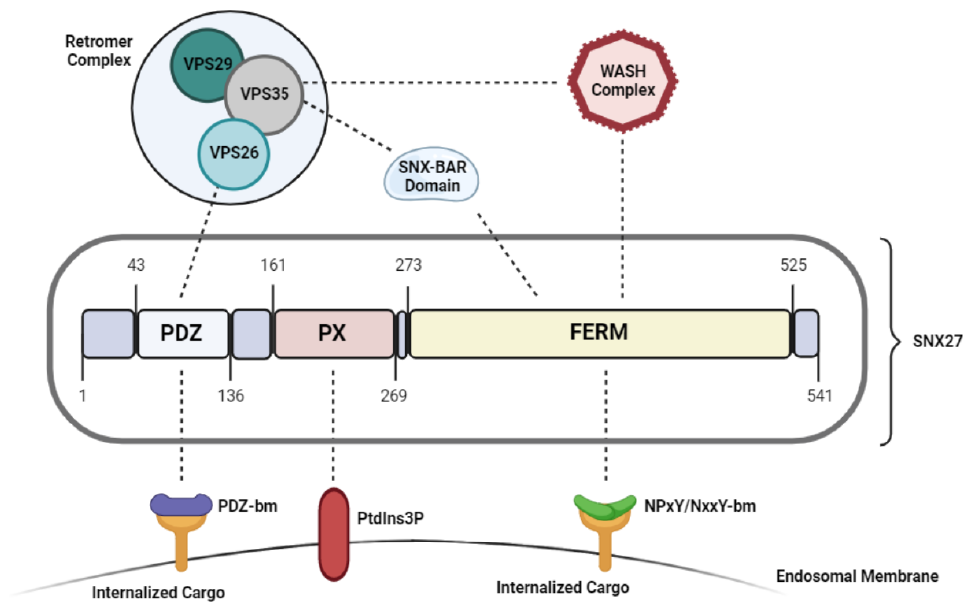
Figure 1. Structure and functional domains of SNX27.